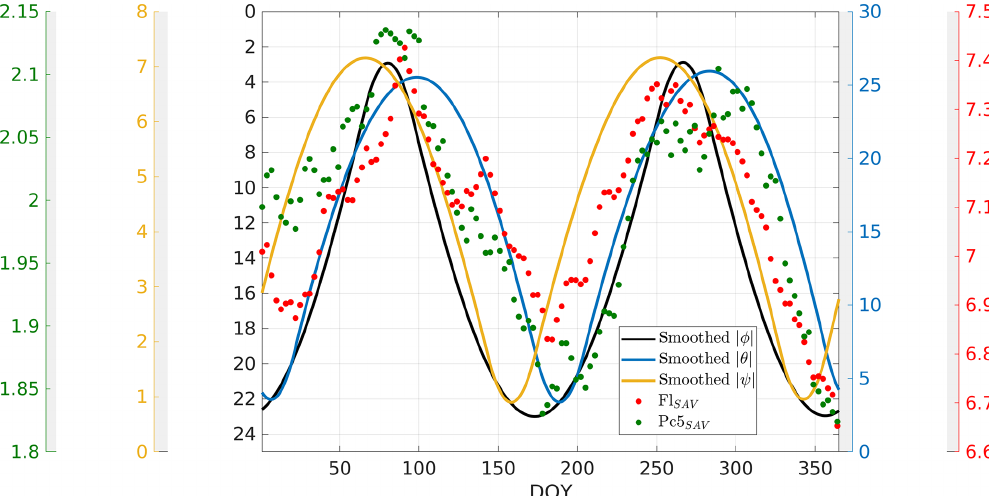
Figure 9. Smoothed absolute value of the angles that control the SAV. φ , θ and ψ are associated to the equinoctial, RM and axial hypotheses, respectively. FL SAV and Pc5 SAV have also been added and plotted at 3d intervals. The 3d interval helps to improve the visualization of the five time